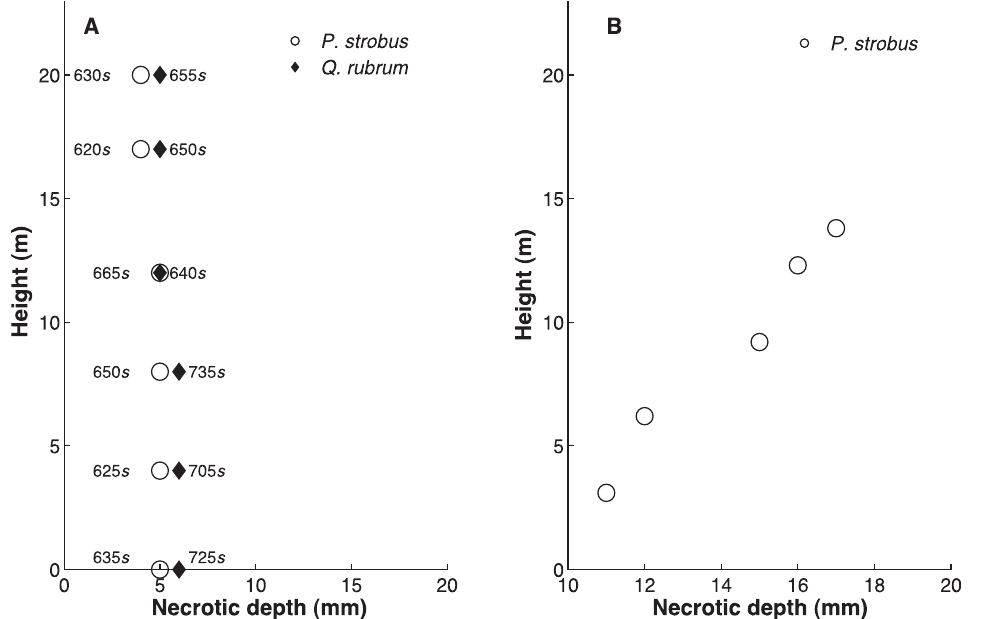
Figure 10. Simulated impact of height (above ground) on necrosis depth in two different virtual experiments. A. Low intensity fire: Necrotic depth in different heights: 0 m, 4 m, 8 m, 12 m, 17 m, 20 m for a P. strobus (solid markers) and a Q. prinus (open markers). The diagram also lists the time at which each necrotic depth was reached. In low intensity fires lower tree levels suffer strongest effects than stem parts higher in the crown. B. Crown Fire: Necrotic depth in different heights: 3.1 m, 6.2 m, 9.2 m, 12.3 m, 13.8 m for a P. strobus . In crown fires higher tree levels are more strongly affected than the lowers parts of the stem.